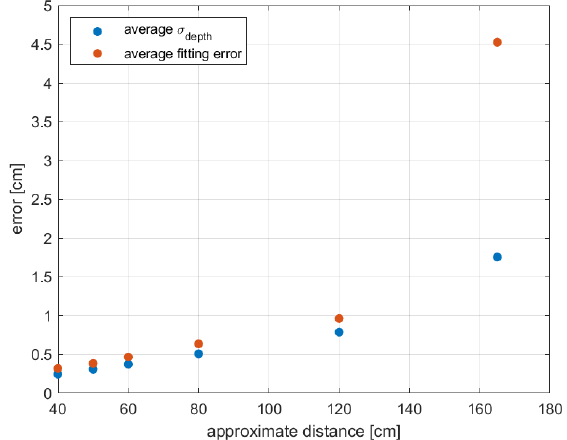
Figure 10. Fitting error and average standard deviation of the depth measurements for acquisitions at different distances from the plane.